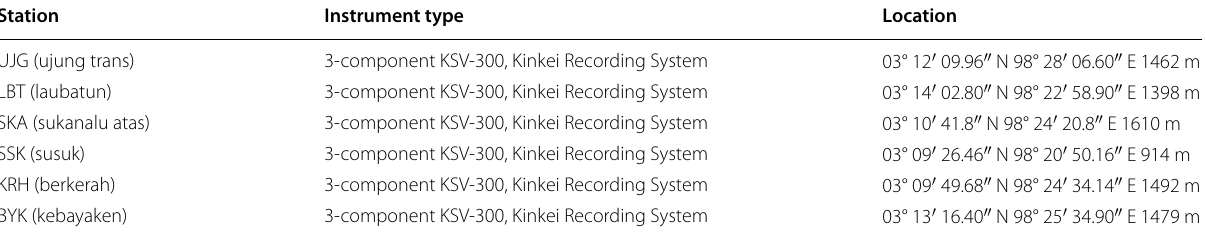
Table 1 Seismic stations used in this